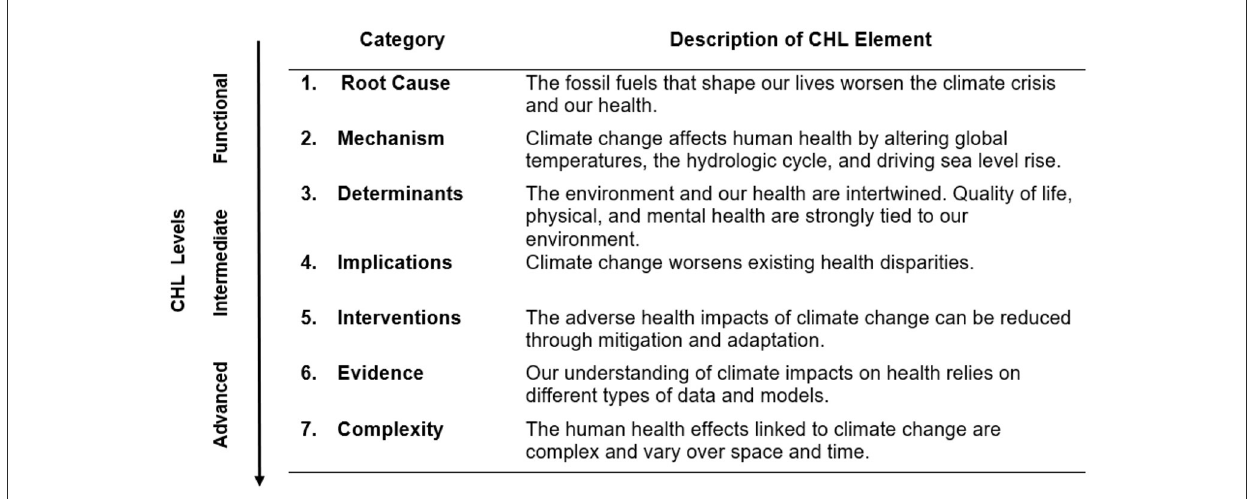
FIGURE1 Climate and health literacy (CHL) elements as adapted from Limaye et al.